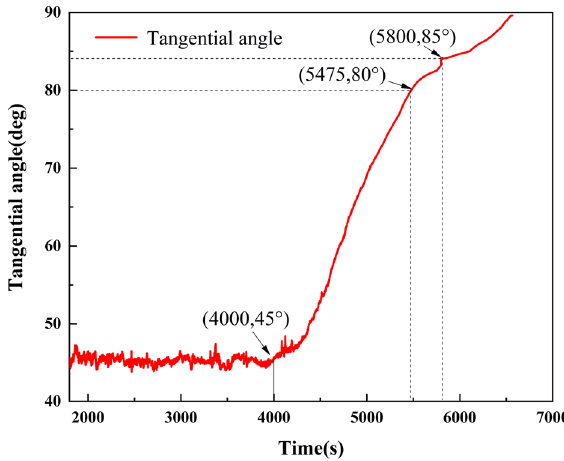
Figure 8. Curve of the tangential angle of T–t curve.